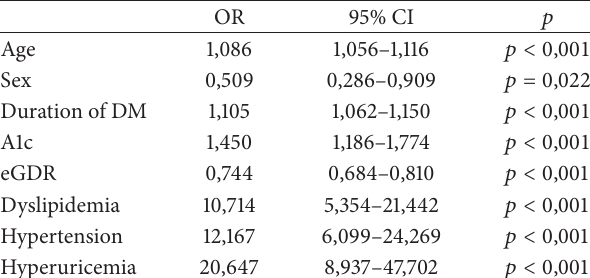
Table 3: The final model of logistic regression for